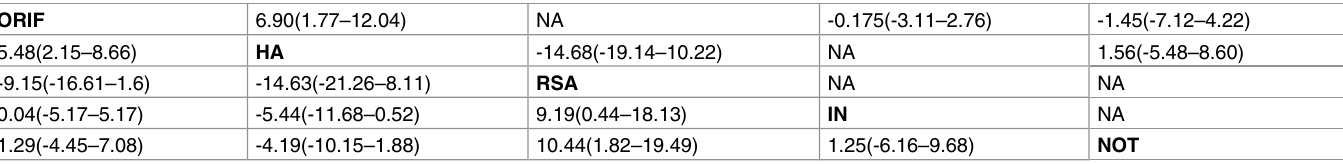
Table 3. Results for constant score, from network meta-analysis (lower diagonal part) and pairwise meta-analysis (upper diagonal part).